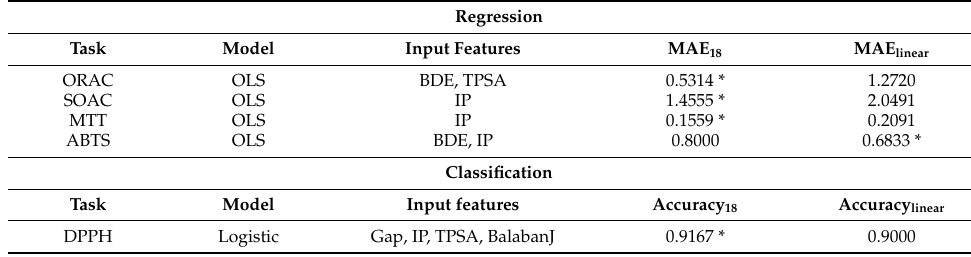
Figure 3. Confusion matrices for DPPH classification. ( a ) The classification performance of test data. ( b ) Plot indicating how well the classification model was trained. A score of 0 means no antioxidant capacity according to the DPPH assay, whereas 1 means that compounds in the area were effective.